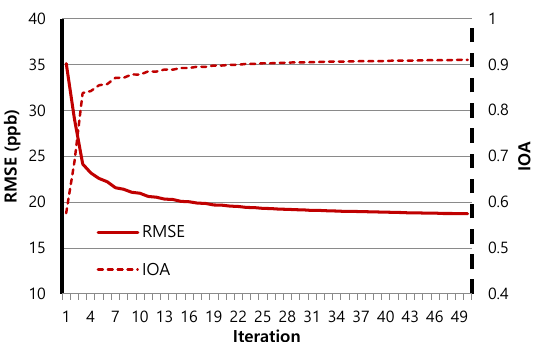
Figure 14. Decreasing root mean square error (RMSE, solid line) and increasing index of agreement (IOA, dashed line) with respect to each iteration step. The RMSE and IOA are calculated by com- paring 4D-Var data assimilation (4D-Var) results during time win- dow with observed O 3 concentration.